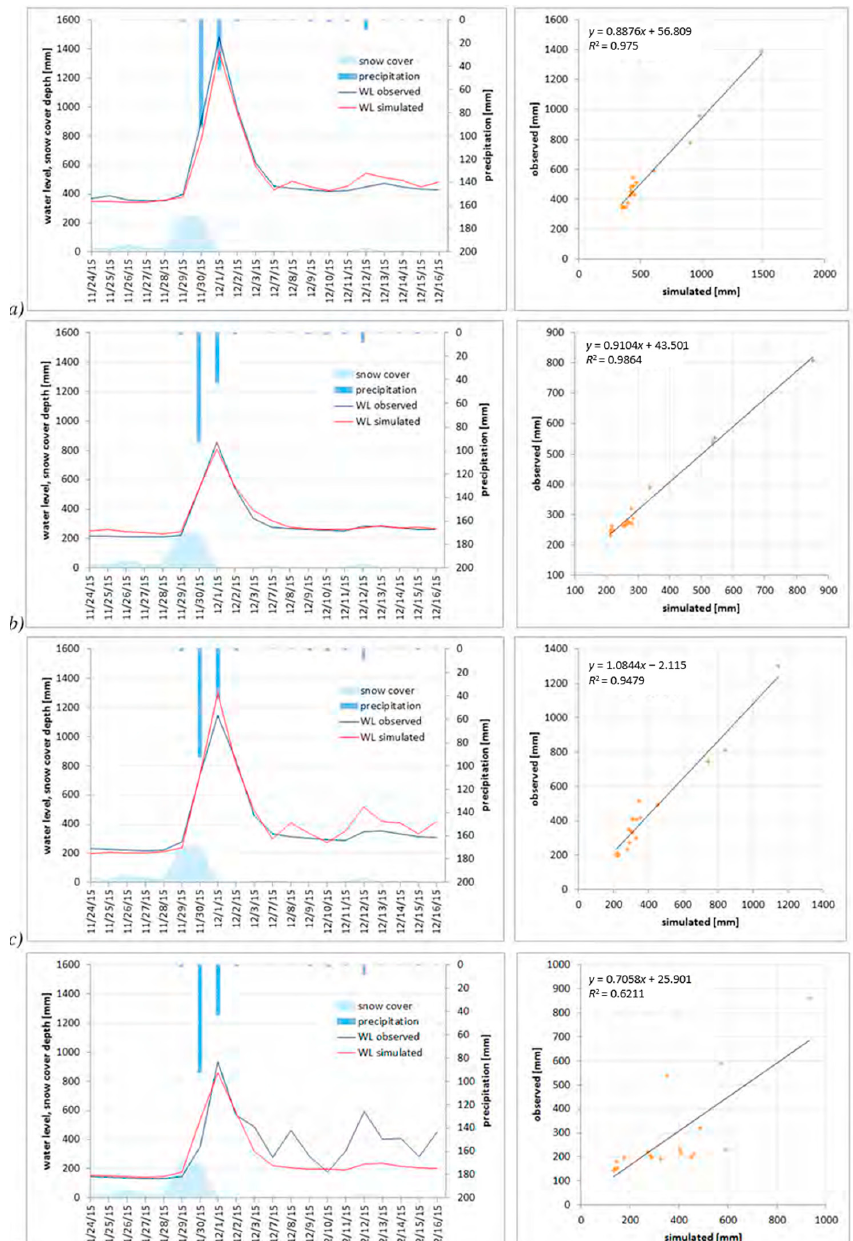
Figure 10. Simulation scenario SC4—rain on snow, 24 November–16 December 2015 at stations: ( a ) RKM; ( b ) JAV; ( c ) ROK; and ( d ) HAJ.